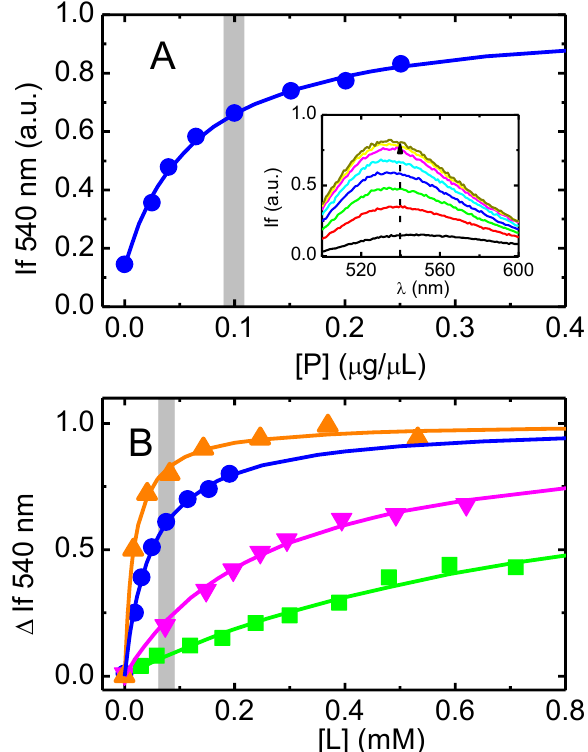
Figure 3. Effect of the native membranes on the NBD amphiphile fluorescence: NBD–C8 ( • , – ), NBD-C6 ( (cid:72) , – ), NBD–C4 ( (cid:4) , – ), and NBD–LysoMPE ( (cid:78) , – ). Plot ( A ) shows the variation in the fluorescence spectra (inset) and in the fluorescence intensity at 540 nm for NBD–C8. Panel ( B ) shows data for all amphiphiles studied. The gray bar indicates the concentration of protein in the native membranes used in the ATPase activity assays, and it was 10 × higher in the IAAP displacement assays. The lines are the best fits considering simple partition, Equation (S3) or (S4), with the parameters in Table 2. The lipid composition of the membranes from High-Five insect cells used in this work was characterized by HPLC-MS, allowing the quantitative characterization of the phospholipids present [39]. Phosphatidylethanolamines were the most abundant, followed by phosphatidylcholines and phosphatidylserines. The acyl composition within each class was also characterized, showing that the most abundant combination has 34 carbons and one unsaturation (most likely from a palmitoyl and an oleoyl fatty acid esterified in positions 1 and 2 of glycerol, respectively). Thus, the lipid bilayer is well modeled by a mixture of POPE, POPC, and POPS at the molar ratios 45:35:20